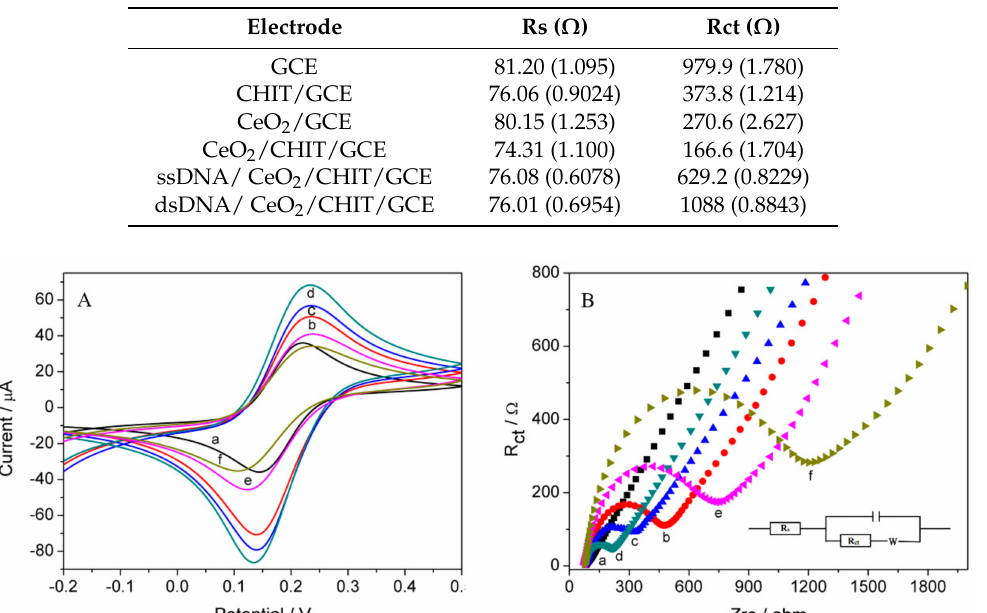
Figure 3. ( A ) CVs; and ( B ) Nyquist diagrams in 0.1 M PBS (pH 7.4) containing 2.0 mmol/L [Fe(CN) 6 ] 3 − /4 − and 0.1mol/L KCl at: (a) GCE; (b) CHIT/GCE; (c) CeO 2 /GCE; (d) CeO 2 /CHIT/GCE; (e) ssDNA/CeO 2 /CHIT/GCE; and (f) dsDNA/CeO 2 /CHIT/GCE. Inset is the equivalent